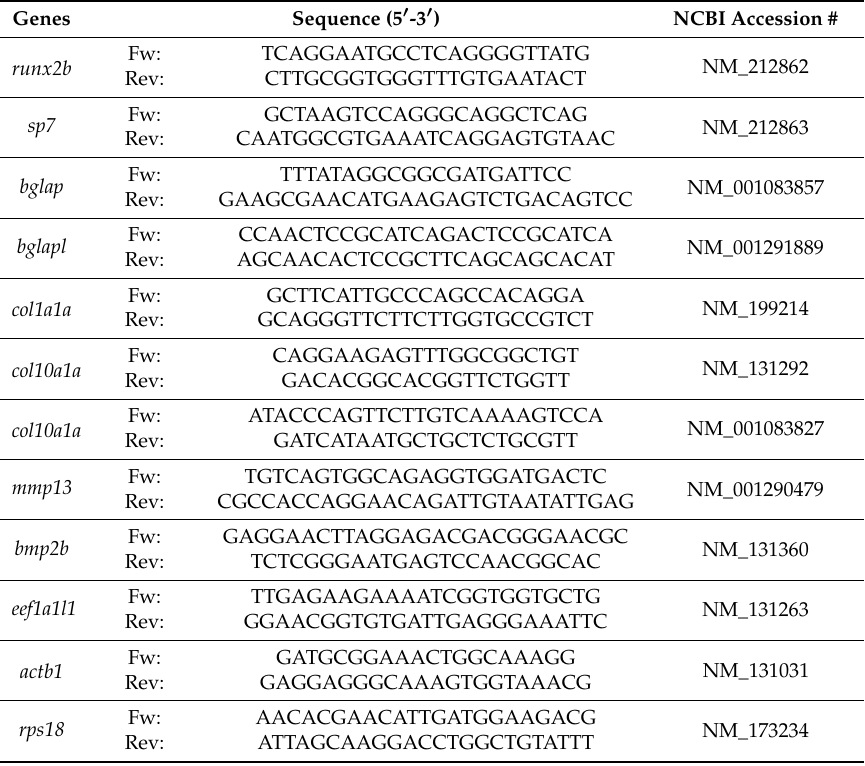
Table 1. PCR primers used in this study to assess gene